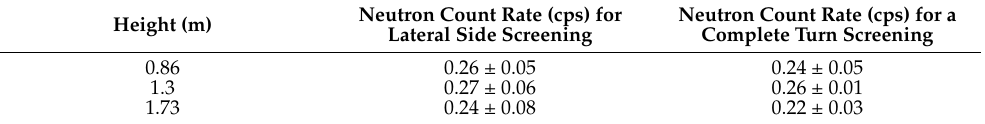
Table 5. Neutron count rate and standard deviation obtained with the EJ-426HD detection system integrated in the drone considering Troxler equipment placed at the center of the shipping container.